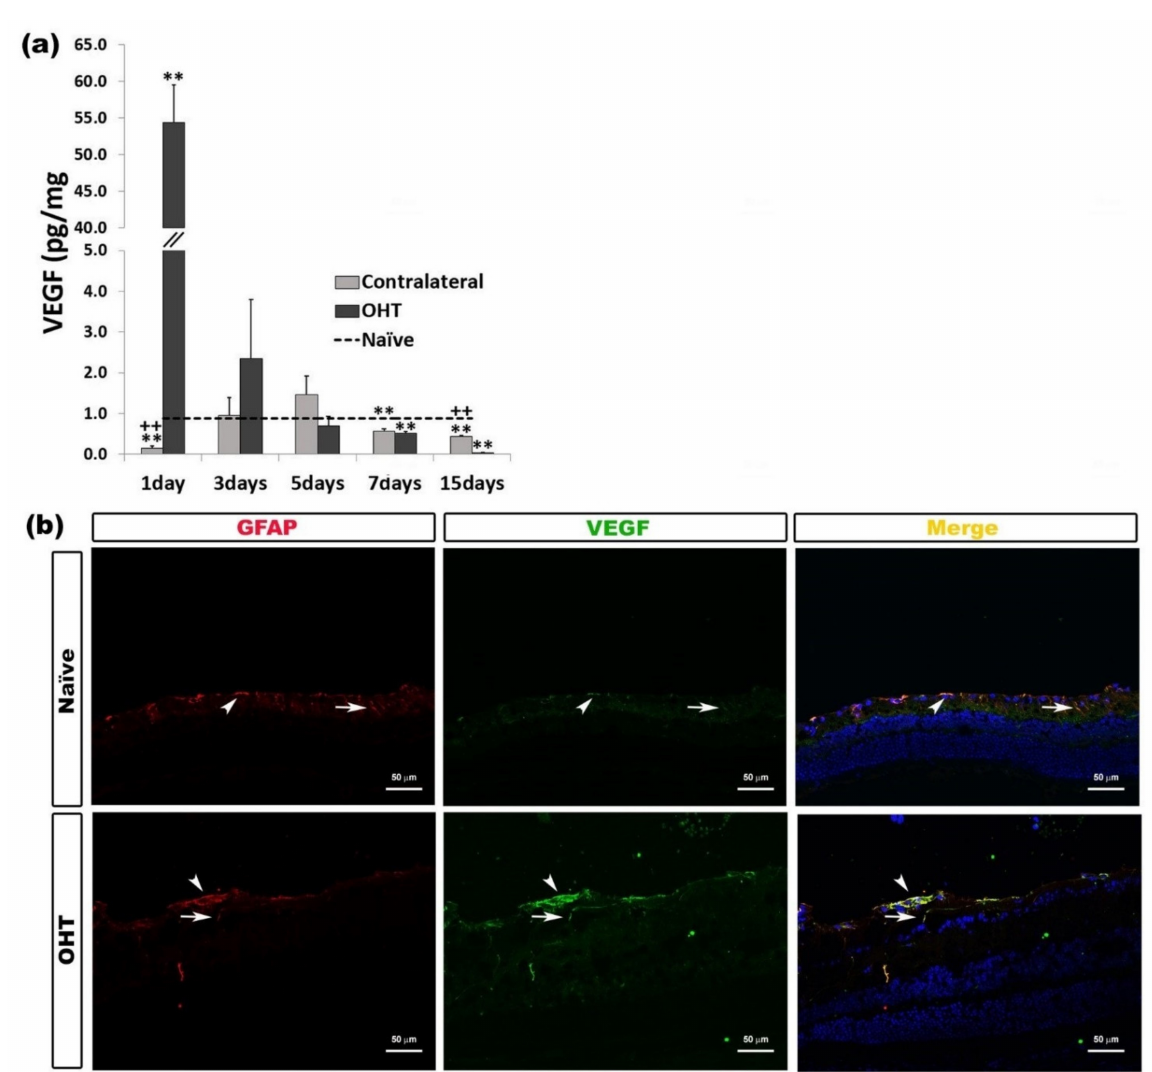
Figure 10. Vascular Endothelial Growth Factor (VEGF) levels at different times after laser-induced ocular hypertension (OHT). ( a ) The variation over time in the VEGF levels in the multiplex assay. The histogram shows the mean levels ( ± SD) of VEGF (pg/mg) at days 1, 3, 5, 7, and 15 after laser OHT induction, in ocular hypertension eyes (OHT) and in contralateral eyes. The dashed line indicates the mean levels in naïve eyes. Statistical significance indicators: ** p < 0.01 vs. naïve; ++ p < 0.01 vs. OHT. ( b ) Immunohistochemical study of VEGF expression in OHT eyes one day after unilateral laser-induced OHT. Retinal sections were immunolabeled with antibodies to VEGF (green) and GFAP (red). Merge (yellow). The arrowheads (astrocytes) and arrows (Müller cells) show the co-expression of GFAP and VEGF, with the expression being higher in OHT than in naïve eyes. Abbreviations: OHT (ocular hypertension); VEGF (vascular endothelial growth factor); GFAP (glial fibrillary acidic